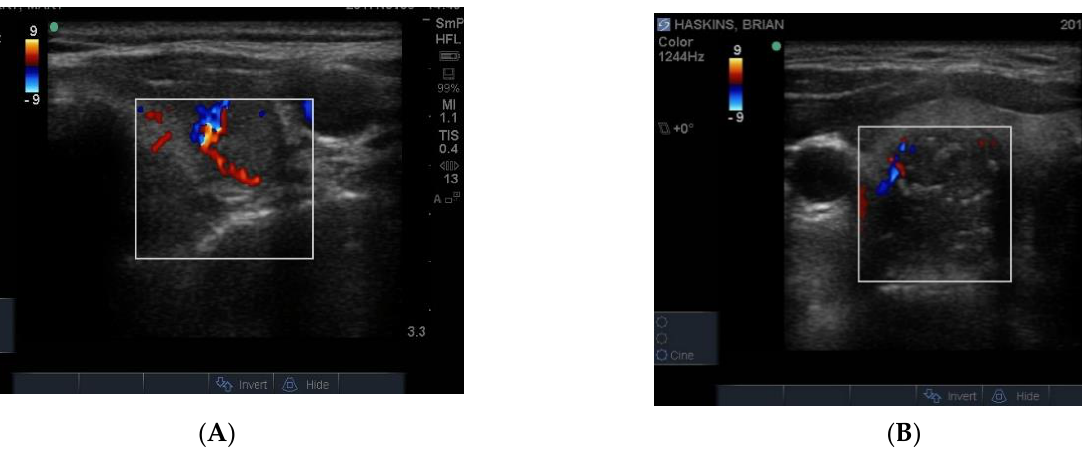
Figure 9. Examples of vascularity around the edge of a benign nodule and ( A ) associated with blotchy macrocalcifications in a hard, irregular edged nodule that is suspicious for papillary cancer ( B ). Another example of macrocalcifications in papillary thyroid